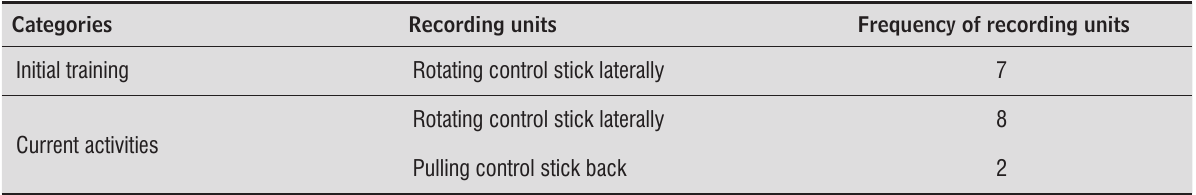
Table 2 - Pilots’ perception on which movement most overloads body during